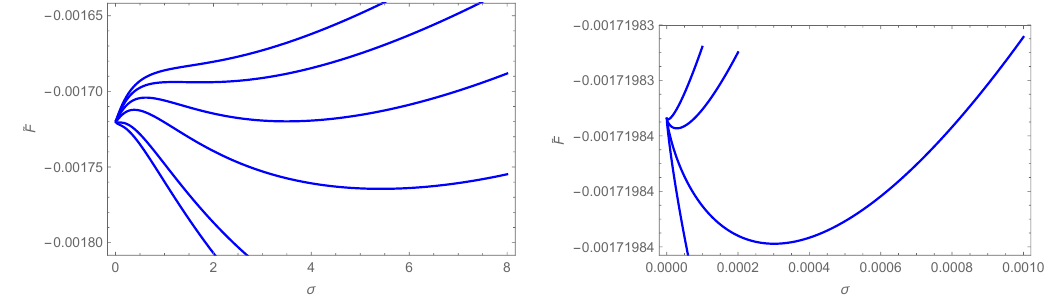
Figure 6 . Free energy landscape at different ensemble temperatures. The right panel is the zoom in picture of the left panel. In the left panel, the ensemble temperatures